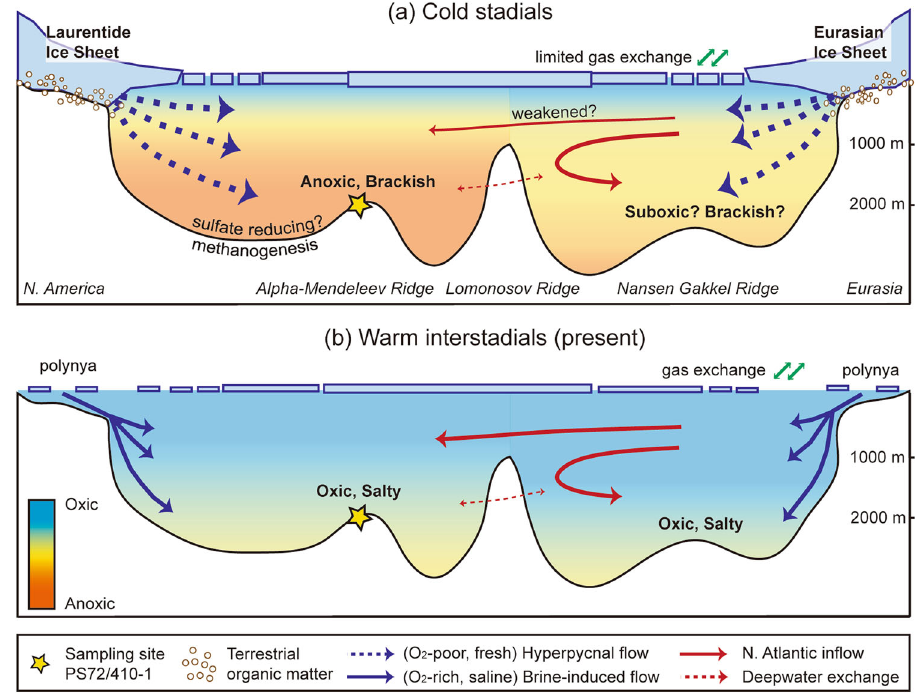
Fig. 6 Schematic illustrations of the oceanic conditions in the Arctic Ocean during two contrasting periods. The anoxic subglacial meltwater underneath the Laurentide and Eurasian Ice Sheets (potentially also East Siberian Ice Sheet; not shown) formed sediment-laden hyperpycnal fl ows, leading to PDW freshening and anoxia during stadials ( a ), while brine formation at the marginal polynya can supply oxygen into the deep basin by vertical mixing during interstadials ( b ). We speculate that oxygen contents in the eastern Arctic Ocean during stadials were slightly more oxygenated than those in the western Arctic Ocean due to limited, but continuous exchange with the North Atlantic in fl ow. Note that the deep water exchange below ~1700 m was likely limited based on the present-day observation that deep water in the western Arctic Ocean crosses the Lomonosov Ridge through the passages in the intra-basin near the North Pole (~1870 m) 75,76 or the southern passage of the southern Lomonosov Ridge (~1700 m) 77 , but the water in fl ow in the opposite way has been yet observed at the depth shallower than ~1700 m 77